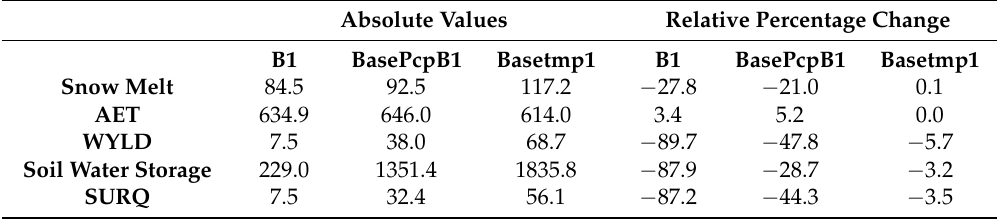
Table A8. Annual variations seen in scenarios B1 (with the combined effect of change in precipitation and temperature), BasePcpB1 (change in temperature), and Basetmp1 (change in precipitation) for the period from 2046–2065. The relative percentage change is with respect to the